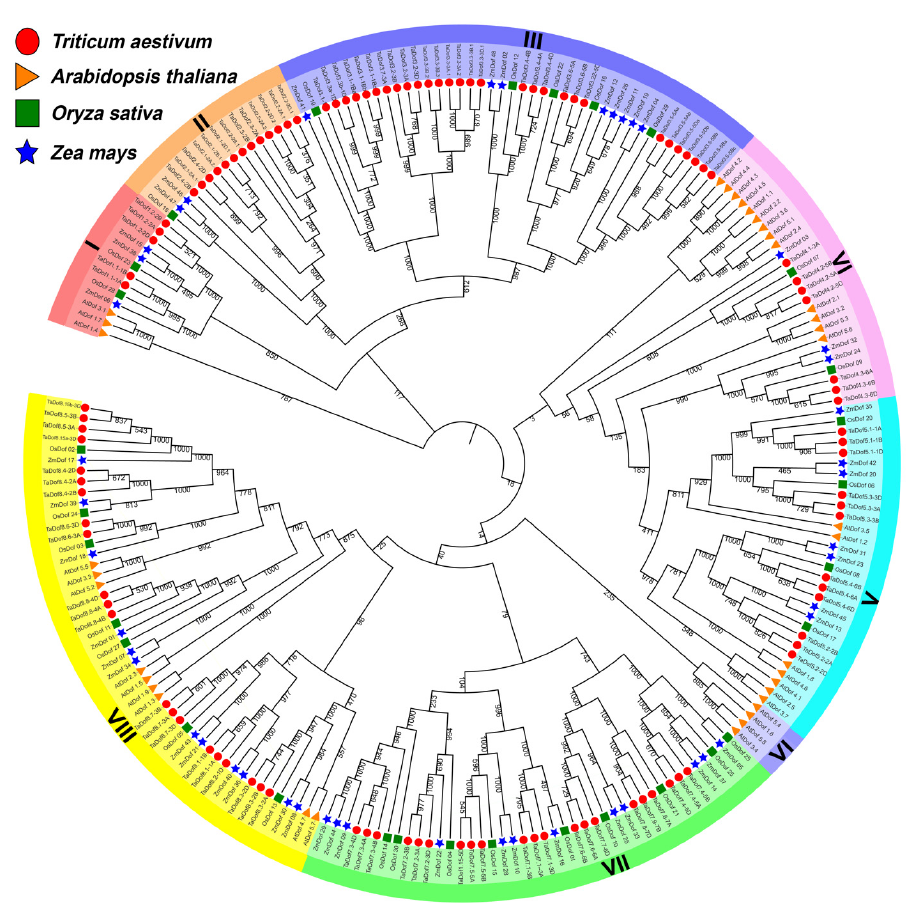
Figure 1. Phylogenetic tree of Dof proteins in wheat, maize, rice, and Arabidopsis. Protein sequences were aligned using ClustalW2 and the phylogenetic tree was constructed using the Bootstrap ML tree method (1000 replicates) in MEGA 7.0 software. Each type is marked by a different color. Bootstrap values are shown on the branches. Dofs from wheat, rice, maize, and Arabidopsis are distinguished by different shapes.